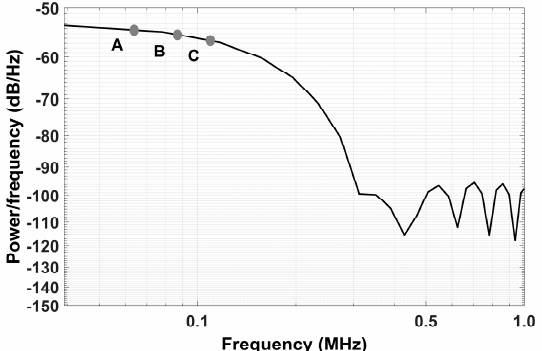
Figure 3. Sensitivity of the piezoelectric transducer in the frequency domain. A, B and C are frequency attenuation of − 1 dB, − 2 dB and − 3 dB, respectively.